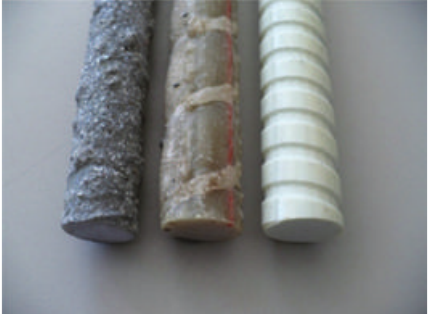
Figure 1: Pultrall V-rod, Aslan 100, and Sch˝ock ComBAR (left to right) [20].